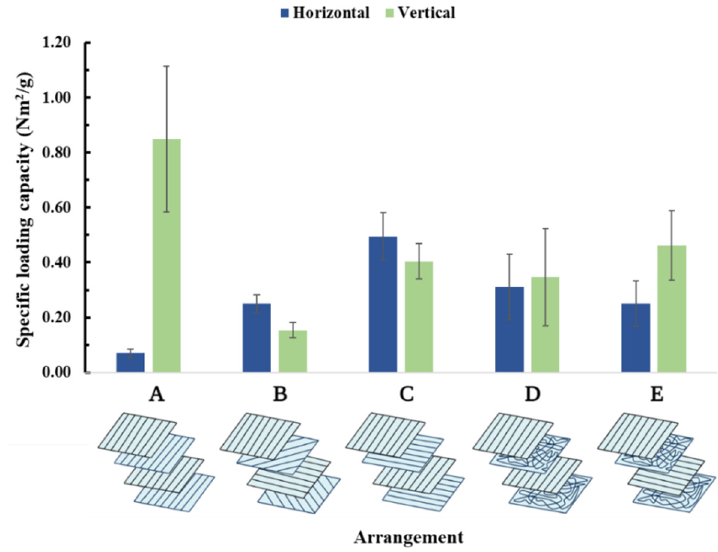
Figure 12. Specific loading capacities of multilayer membranes.